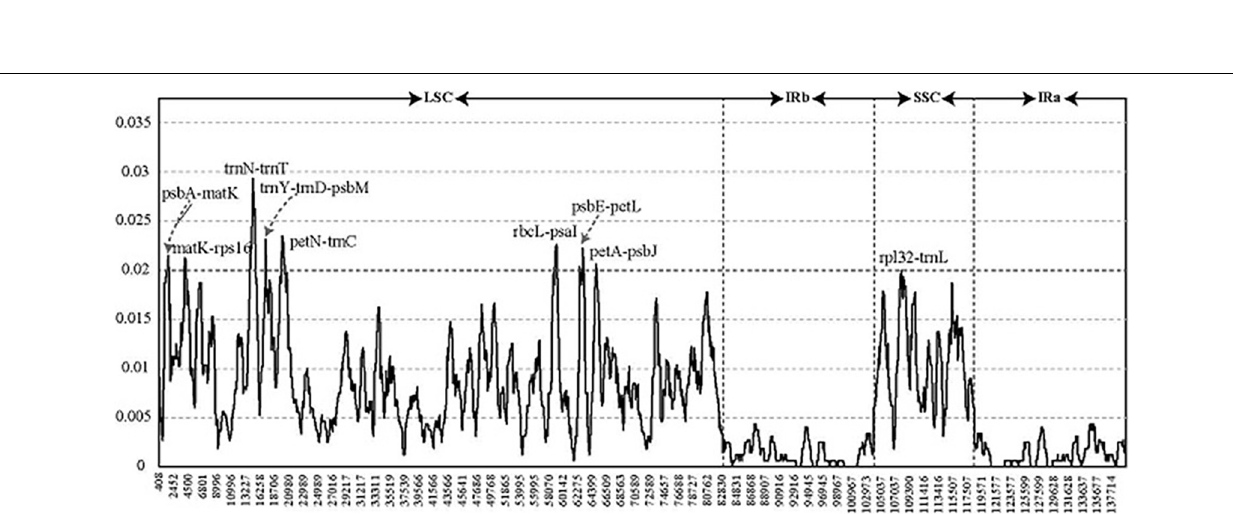
FIGURE 3 | Comparison for border positions of LSC, SSC, and IR regions among four Pennisetum . Genes are denoted by boxes, and the gap between the genes and the boundaries is indicated by the number of bases unless the gene coincides with the boundary. Extensions of genes are also indicated above the boxes.